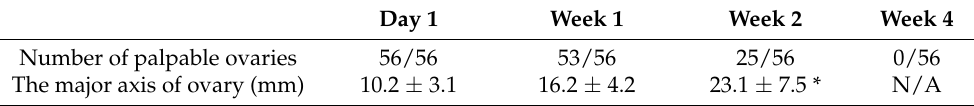
Figure 1. Periodical transrectal ultrasonography at postoperative observation period. Ultrasound scanning to ovaries at day 1 prior to surgery ( A ), and week 1 ( B ) and week 2 ( C ) after surgery. The image for week 4 is unavailable due to dropped ovaries into the abdomen. Asterisks indicate the margin of ovaries. Table 2. Postoperative ultrasonography of spayed heifer.